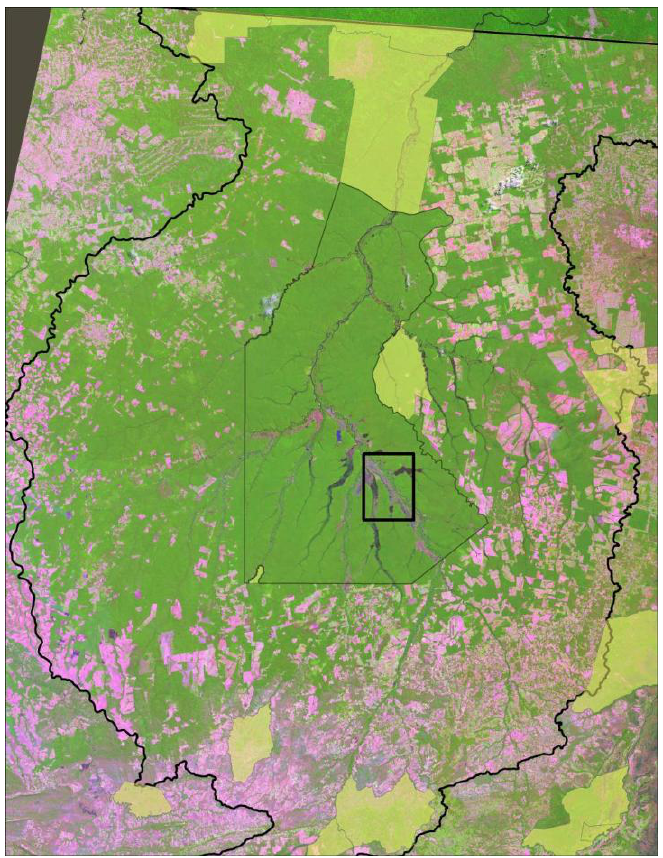
Figure 1. Study area (box) in the Upper Xingu basin (black line). Note: the Parque Indígena do Xingu is marked by a thin black line, other indigenous areas in light green, and upland open woodlands and areas of agro-pastoral development in